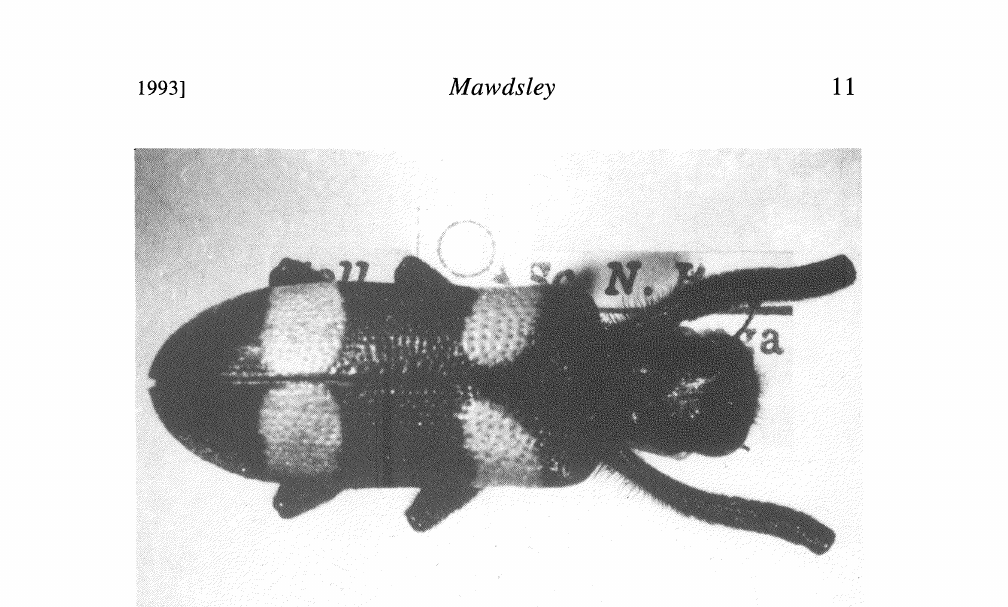
Figure 1: Male Dieropsis quadriplagiata Gahan taken in copula with female shown in Figure 2 by F. G. Overlaet at Kafakumba, Katanga, Belgian Congo (ex INSB). Length of specimen 27.6 mm.